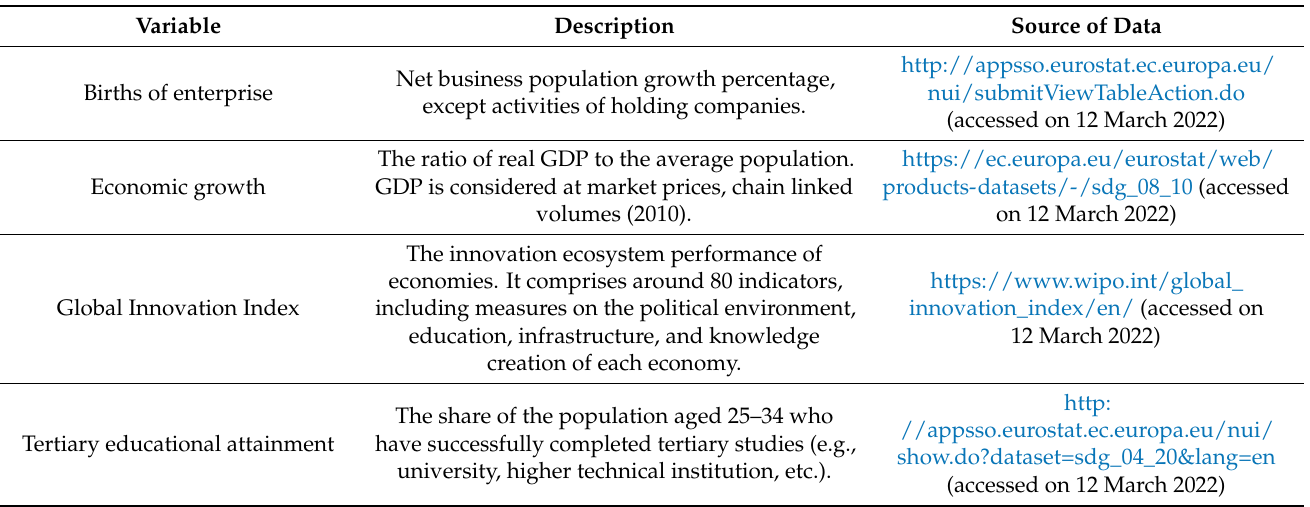
Table 1. Description of the variables and source of